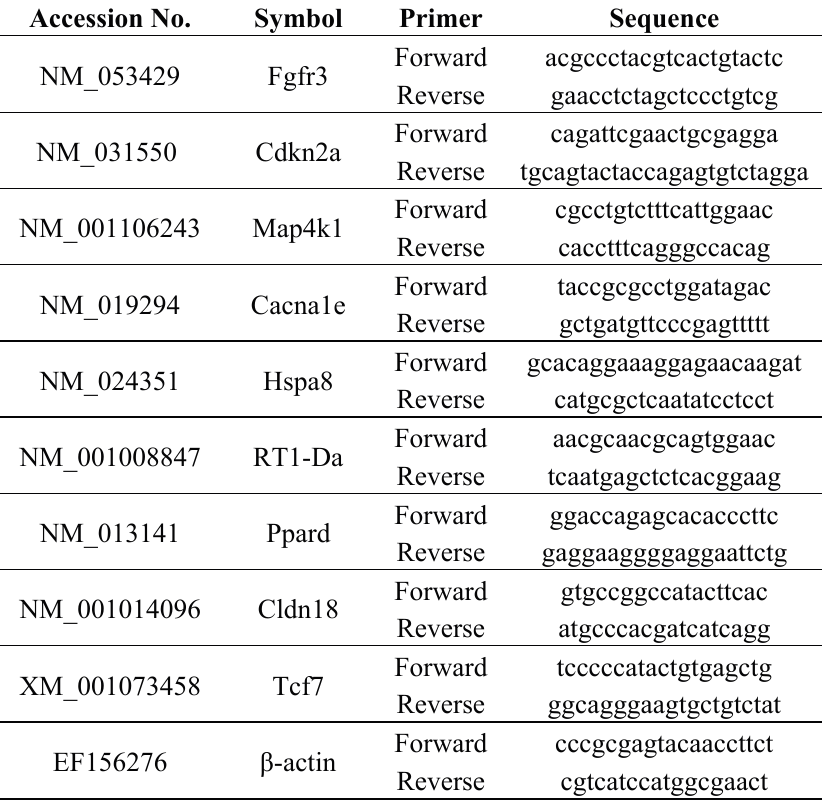
Table 7. Oligonucleotides primers used in this study for quantitative